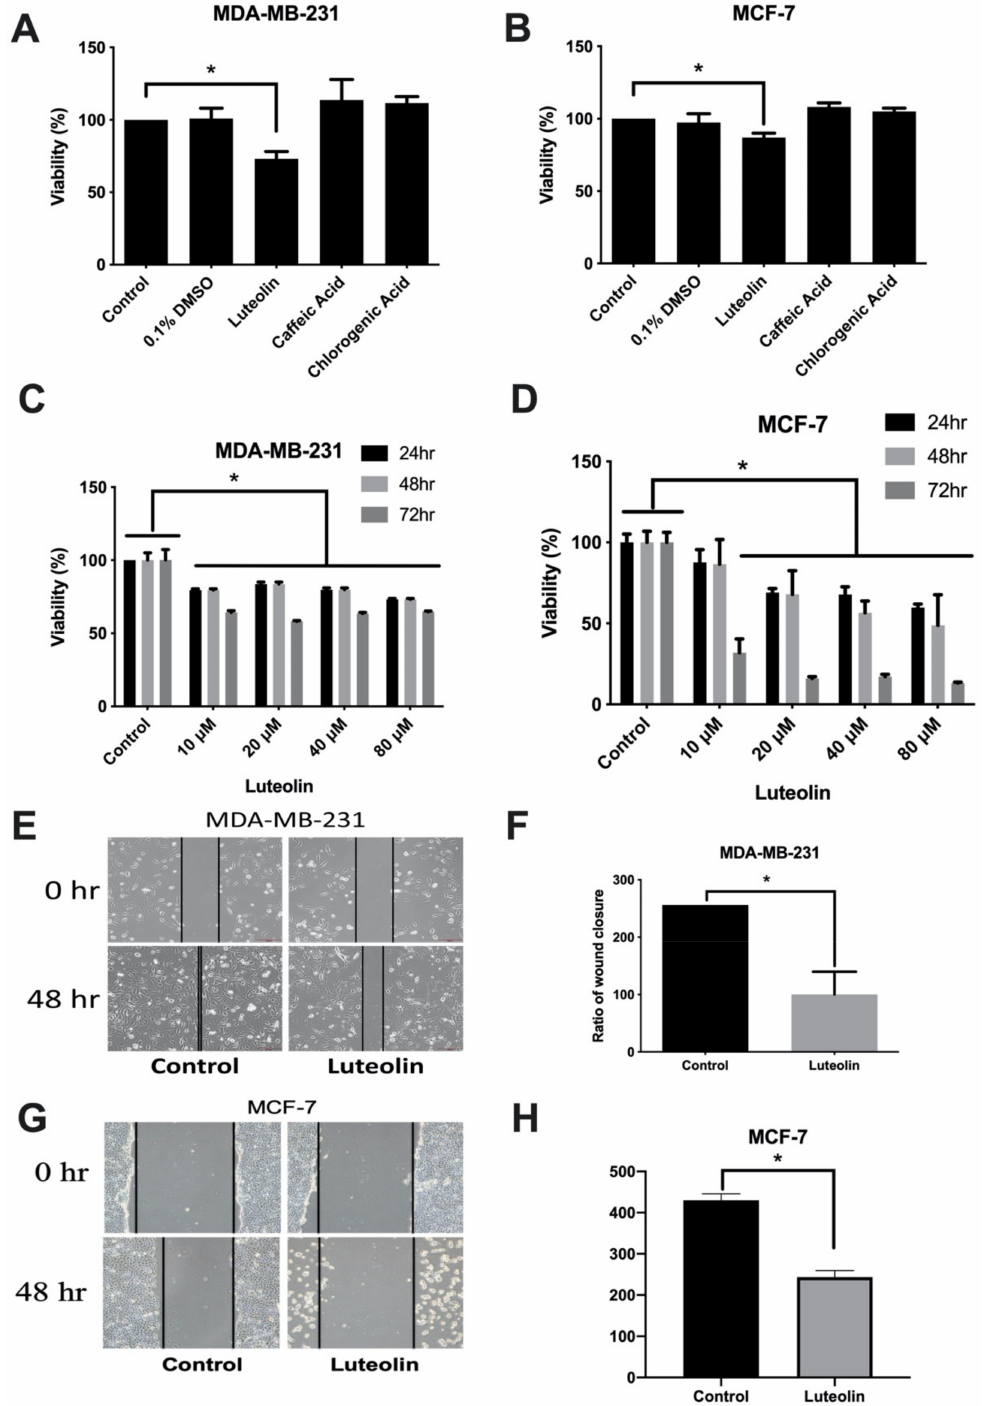
Figure 1. Luteolin mediates the proliferation and migration of breast cancer cells. Breast cancer cells were exposed to 20 µ M luteolin, caffeic acid and chlorogenic acid for 24 h. The growth of ( A ) MDA-MB-231 and ( B ) MCF-7 cells was analyzed using a CCK-8 assay. The dose-/time-dependent effects of luteolin were also analyzed using a CCK-8 assay in ( C ) MDA-MB-231 and ( D ) MCF-7 cells. ( E , G ) Migration was assessed using a wound healing assay. The horizontal dashed line indicates the width of the wound. ( F , H ) Results of quantitative analysis of the wound healing assay. The data are presented as the mean ± SD of three experiments. * p < 0.05 versus untreated